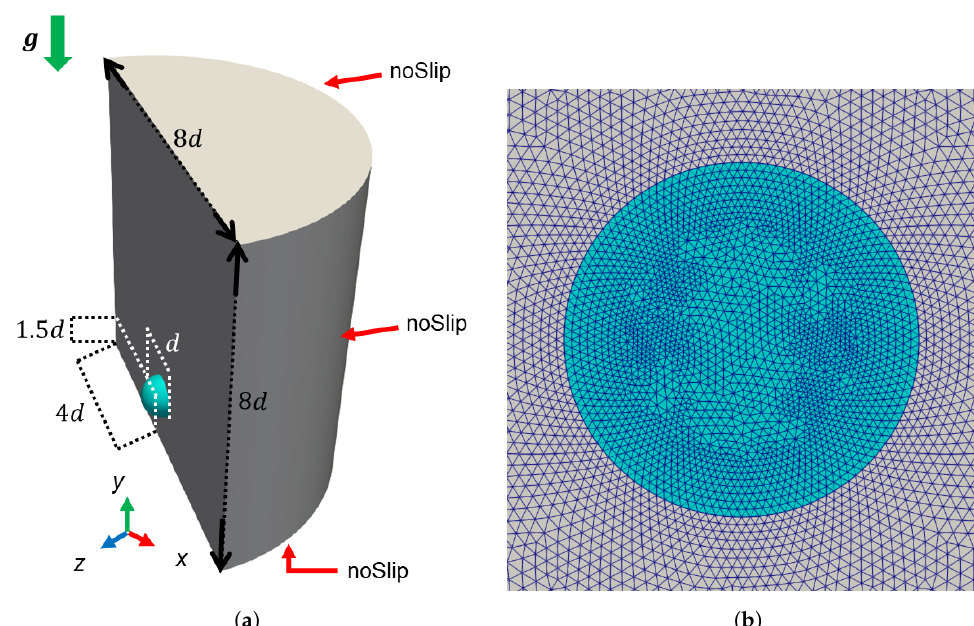
Figure 8. Half computational domain, BCs, ICs ( a ) and mesh detail on the xz plane that cuts the bubble in half at t = 0 ( b ) for the 3D rising bubble test. The bubble, coloured in cyan, is represented through the isovolume 0 ≤ α ≤ 0.5.